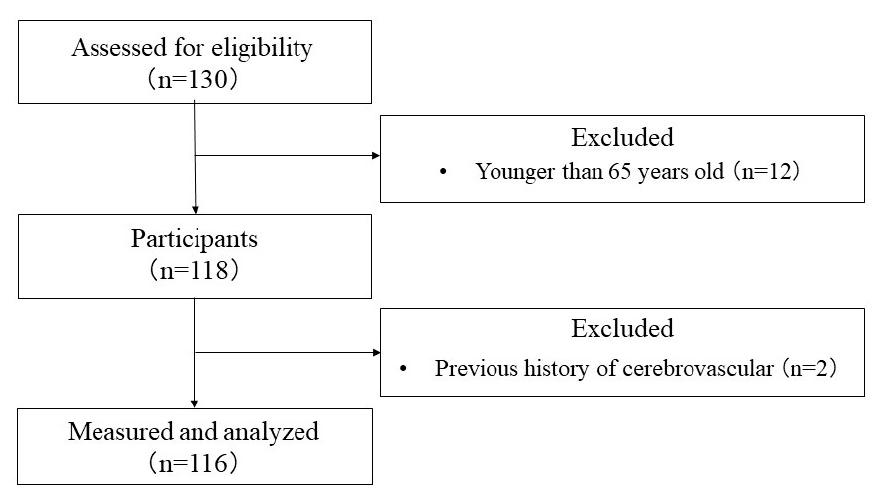
Figure 1. Flowchart of the selection process of the study participants .